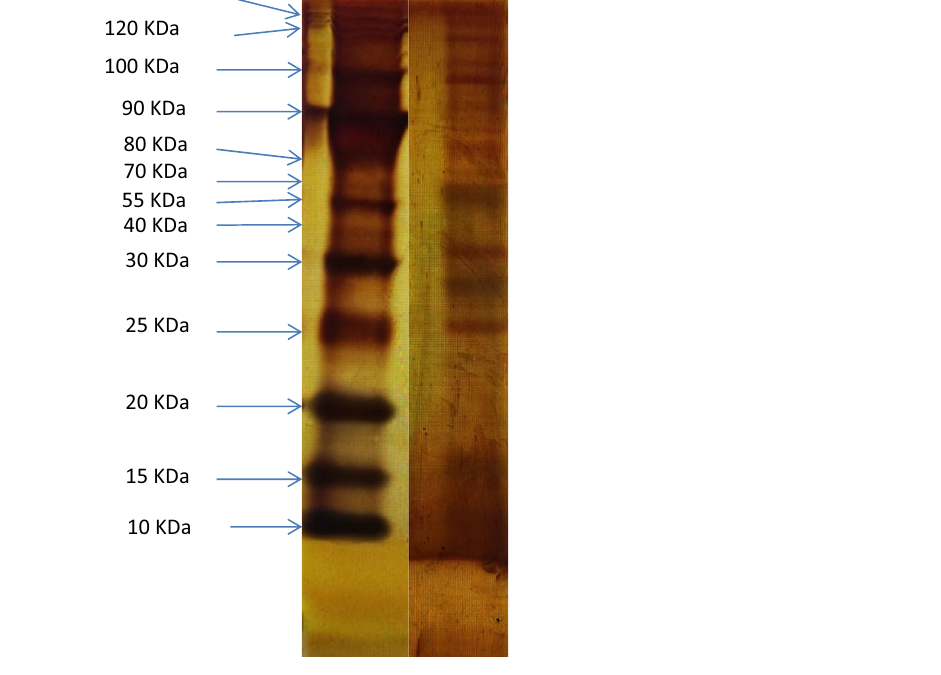
Figure 4. E. vermicularis egg antigen bands in silver-stained gel after SDS-PAGE. Lane 1—BenchMark ® unstained protein marker (10 kDa to 220 kDa); Lane 2—bands of E. vermicularis egg proteins (ranging from 18 to 151 kDa).